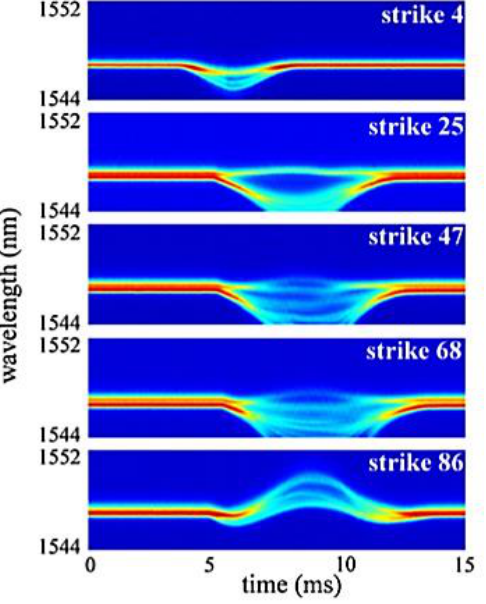
Figure 17. Full-spectral FBG response after different strike numbers [133].